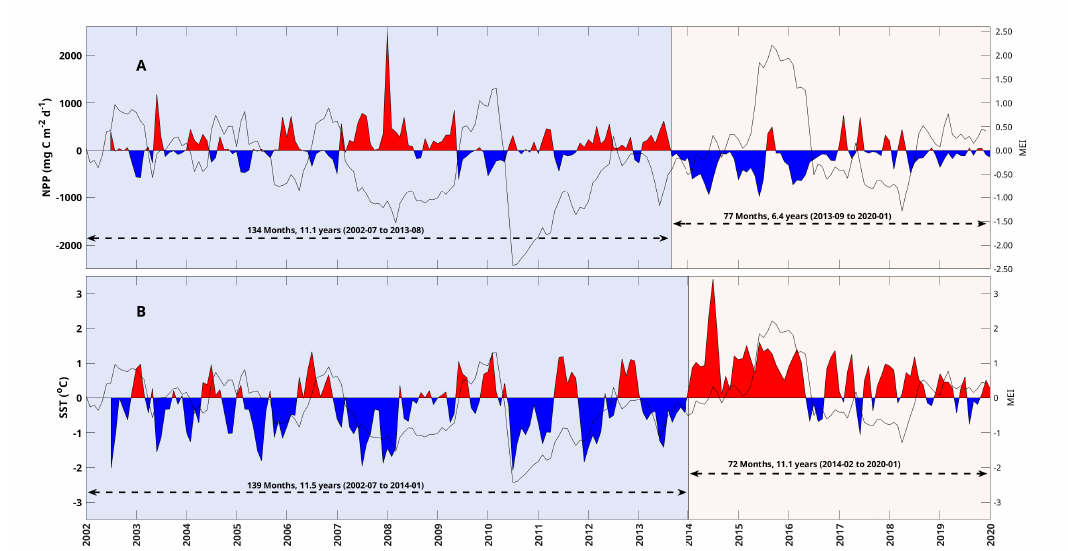
Figure 5. Interannual anomalies of ( A ) net primary productivity (NPP) and ( B ) sea surface temperature (SST) during 2002–2020. The gray line corresponds to the multivariate El Niño/Southern Oscillation (ENSO) index (MEI). The blue (cold) period corresponds to the first regime (2002–2007 to 2013–2014) and the pink (warm) period corresponds to the second regime (2014 to